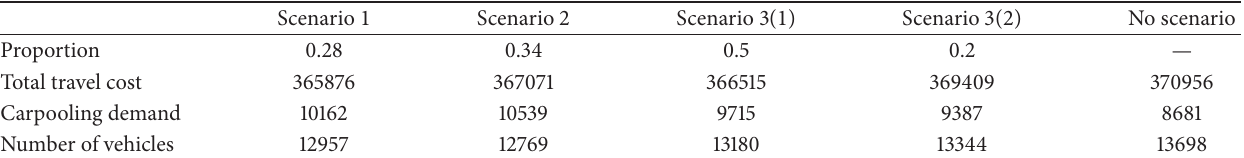
Table 5: Performances of the scenarios.